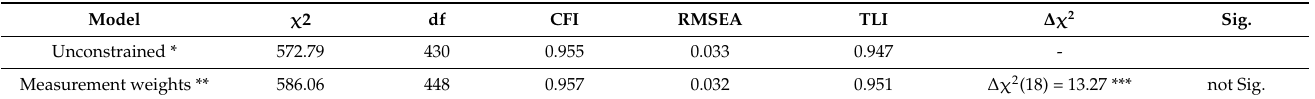
Table 5. Measurement uniformity analysis results.